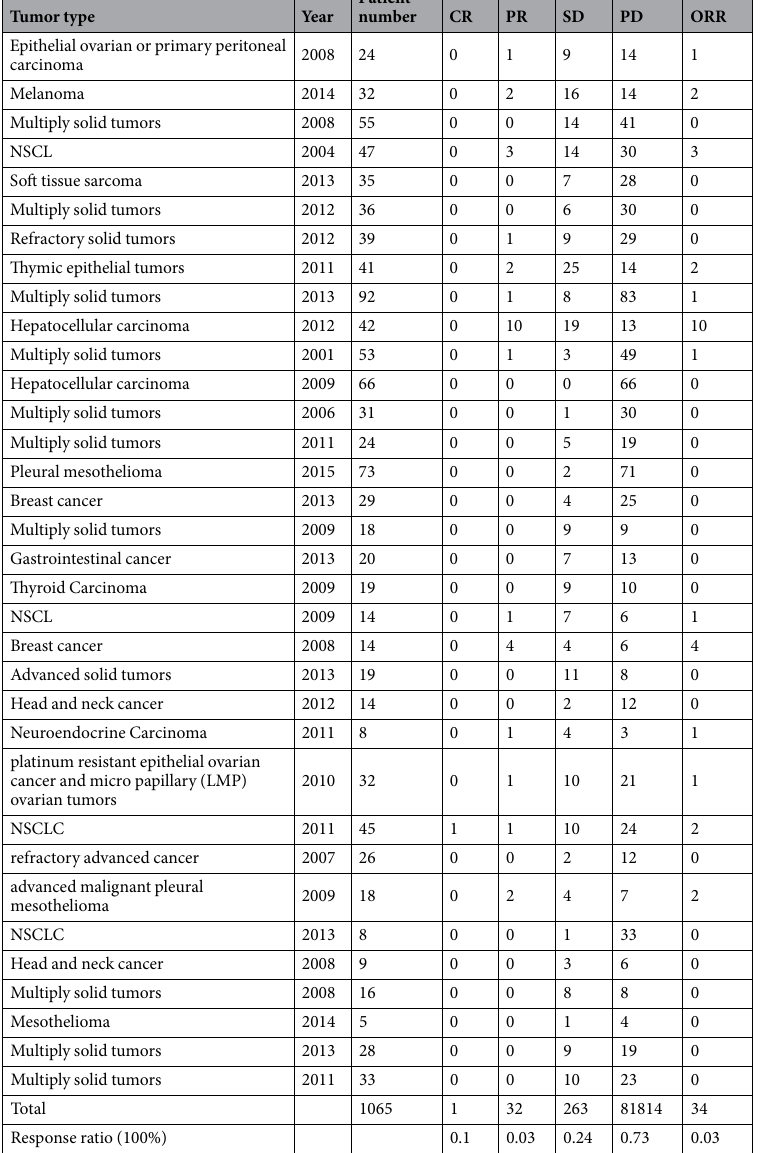
Table 2. Clinical trials of epigenetic drugs alone used in solid tumors (1100 cases). CR, complete response; PR, partial response; SD, stable disease; PD, progressive, disease; ORR (CR + PR), objective response ratio. Response identification based on. Response Evaluation Criteria In Solid Tumors (RECIST). (See references in supplementary